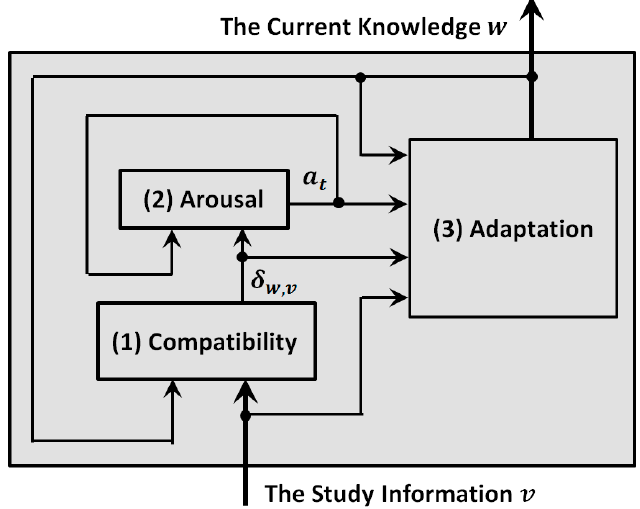
Figure 2. Diagram of the participatory learning mechanism.